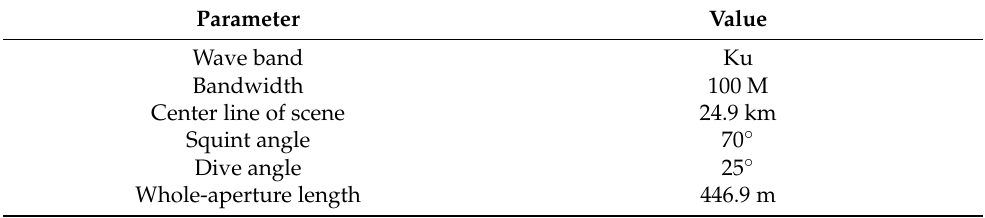
Table 5. Main system